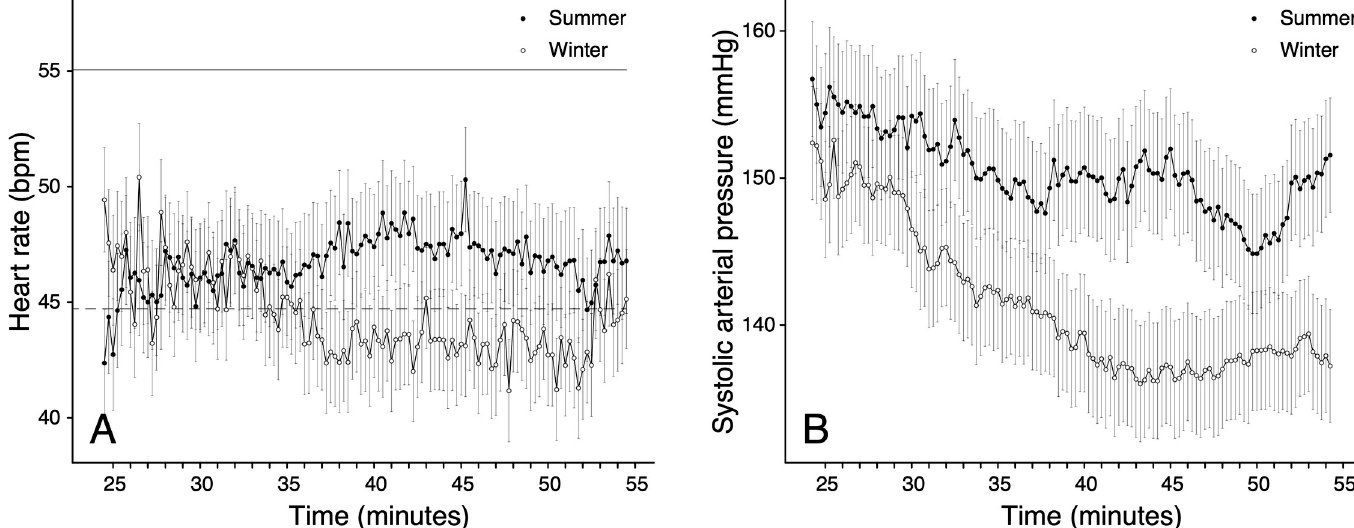
Fig 2. Seasonal differences of heart rate (A) and direct systolic arterial pressure (B) of female red deer ( Cervus elaphus) . Deer (n = 11) were anaesthetised with 0.1 mg/kg medetomidine and 3 mg/kg tiletamine-zolazepam. Heart rate and SAP were measured from minute 25 to 55 after anaesthesia induction (means ± standard error of the mean). Baseline heart rate values for summer (solid) or winter (dashed) season are represented by a horizontal